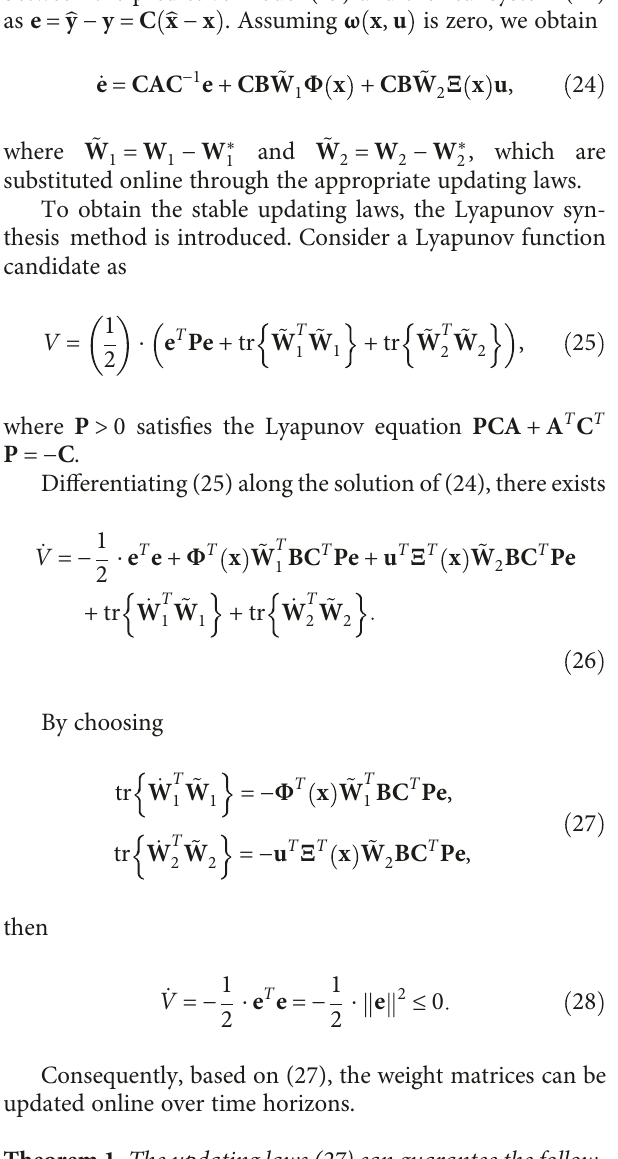
Figure 4: The block diagram of the dynamical